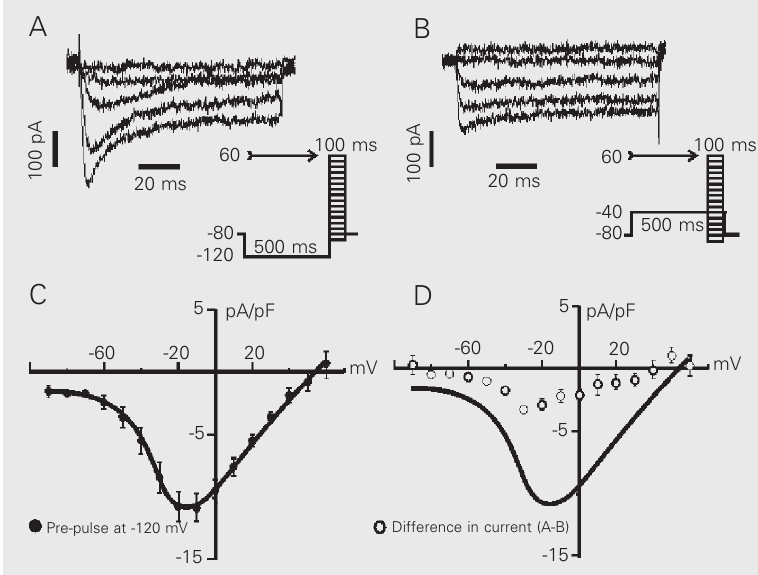
Figure 2. Current-voltage relationships (I-V) in GH3 cells. A , Current traces evoked by depolarizations from -60 mV to -20 mV (holding potential -80 mV, pre-pulse -120 mV). B , Current traces elicited by depolarizations from -50 mV to -10 mV (holding potential -80 mV, pre-pulse -40 mV). C , Averaged density current-voltage relationship obtained for GH3 Ca 2+ currents (filled circles, N = 15). Currents were normalized to cell capacitance to avoid variability due to cell size. D , Averaged current density-voltage relationships for peak currents obtained using a pre-pulse at -120 mV (continuous line), and after subtracting current traces between the two different holding potentials (Figure 2D, open circles, N = 7). All recordings were done using 5 mM calcium as the charge carrier. Data in panels C and D are reported as means ± SEM.